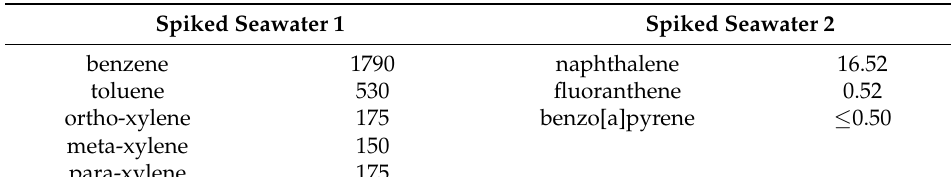
Table 3. Concentration (ppm) of seawater spiked with mono-aromatic hydrocarbons (benzene, toluene, ortho-, meta- and para-xylene) and spiked with polyaromatic hydrocarbons (naphthalene, fluoranthene and benzo[a]pyrene) measured by SBSE/GC-MS.